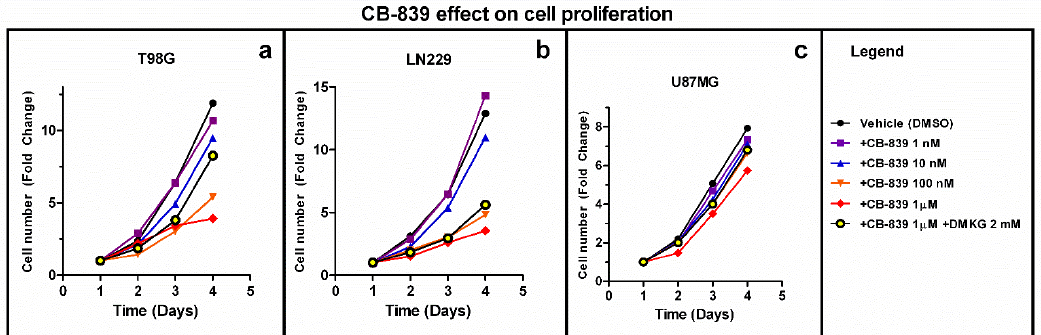
Figure 1. CB-839 inhibits the proliferation of GBM cells in a dose-dependent manner in T98G ( a ), LN229 ( b ) and U87MG ( c ). Dimethyl alpha-ketoglutarate (DMKG) was employed as a metabolic rescue. For each cell line, three independent experiments were made in triplicate. The fold-change in cell number, referring to cells on day 1, is shown.